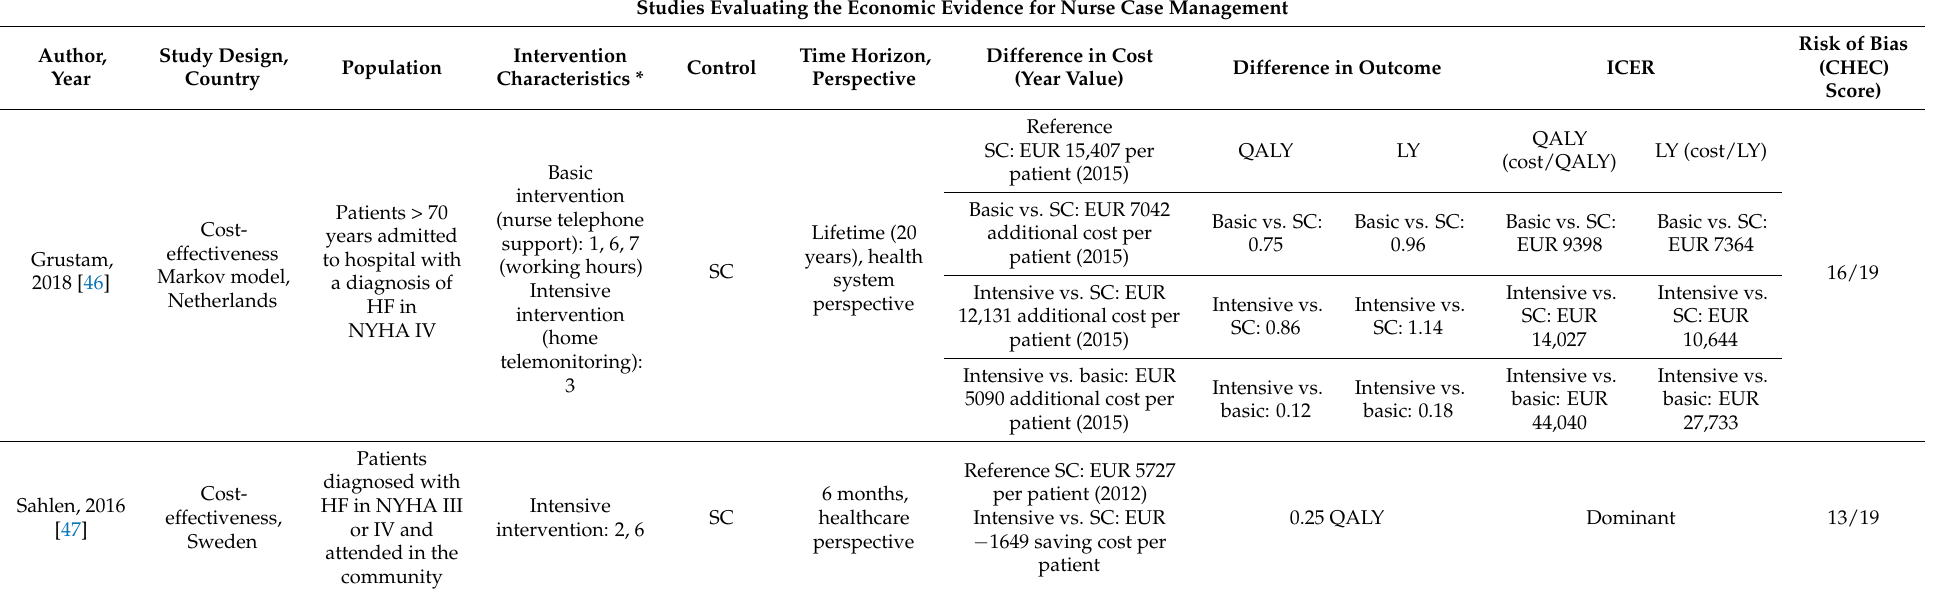
Table 2. Cont. Studies Evaluating the Economic Evidence for Nurse Case